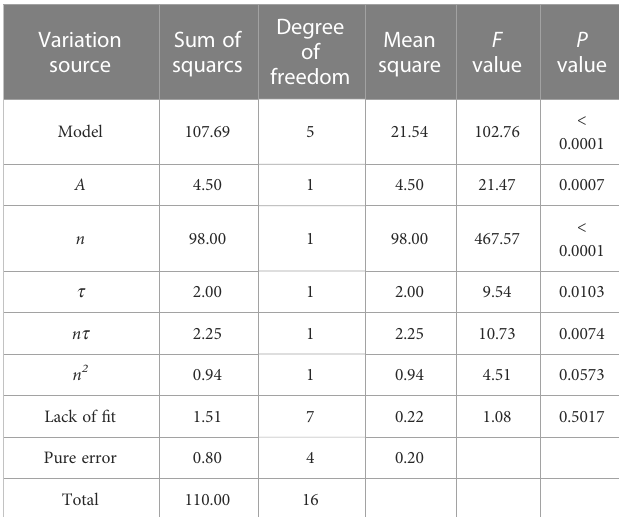
TABLE 9 ANOVA of job width.